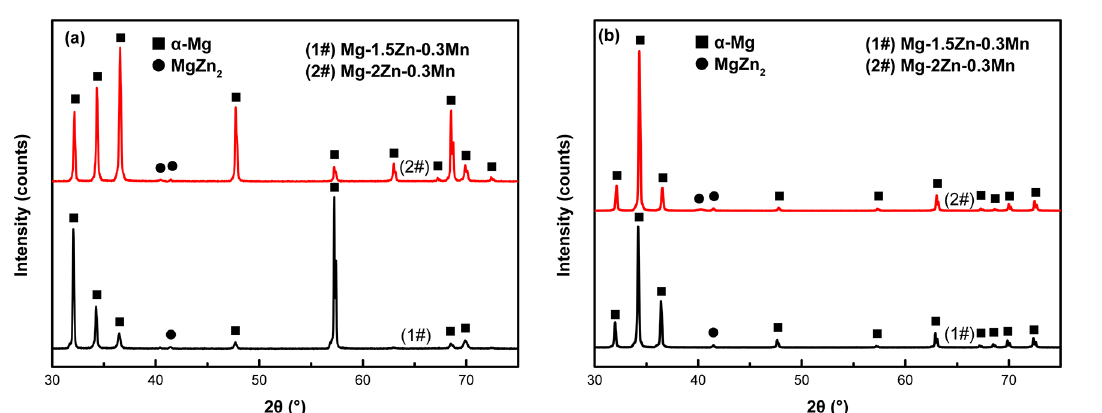
Figure 1. XRD patterns of Mg-xZn-0.3Mn alloys.(a) as-cast samples, (b) as-extruded samples.